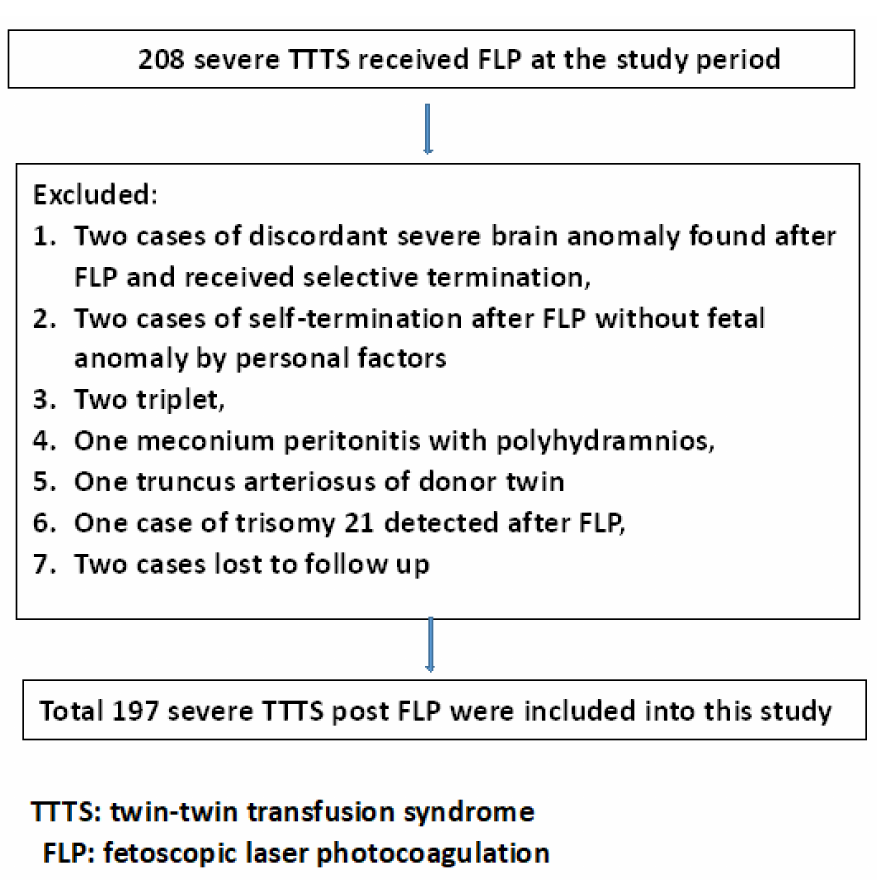
Figure 1. Flowchart of the inclusion and exclusion of patients with severe TTTS who received FLP. Table 1. Basic characteristics of patients with twin–twin transfusion syndrome after fetoscopic laser